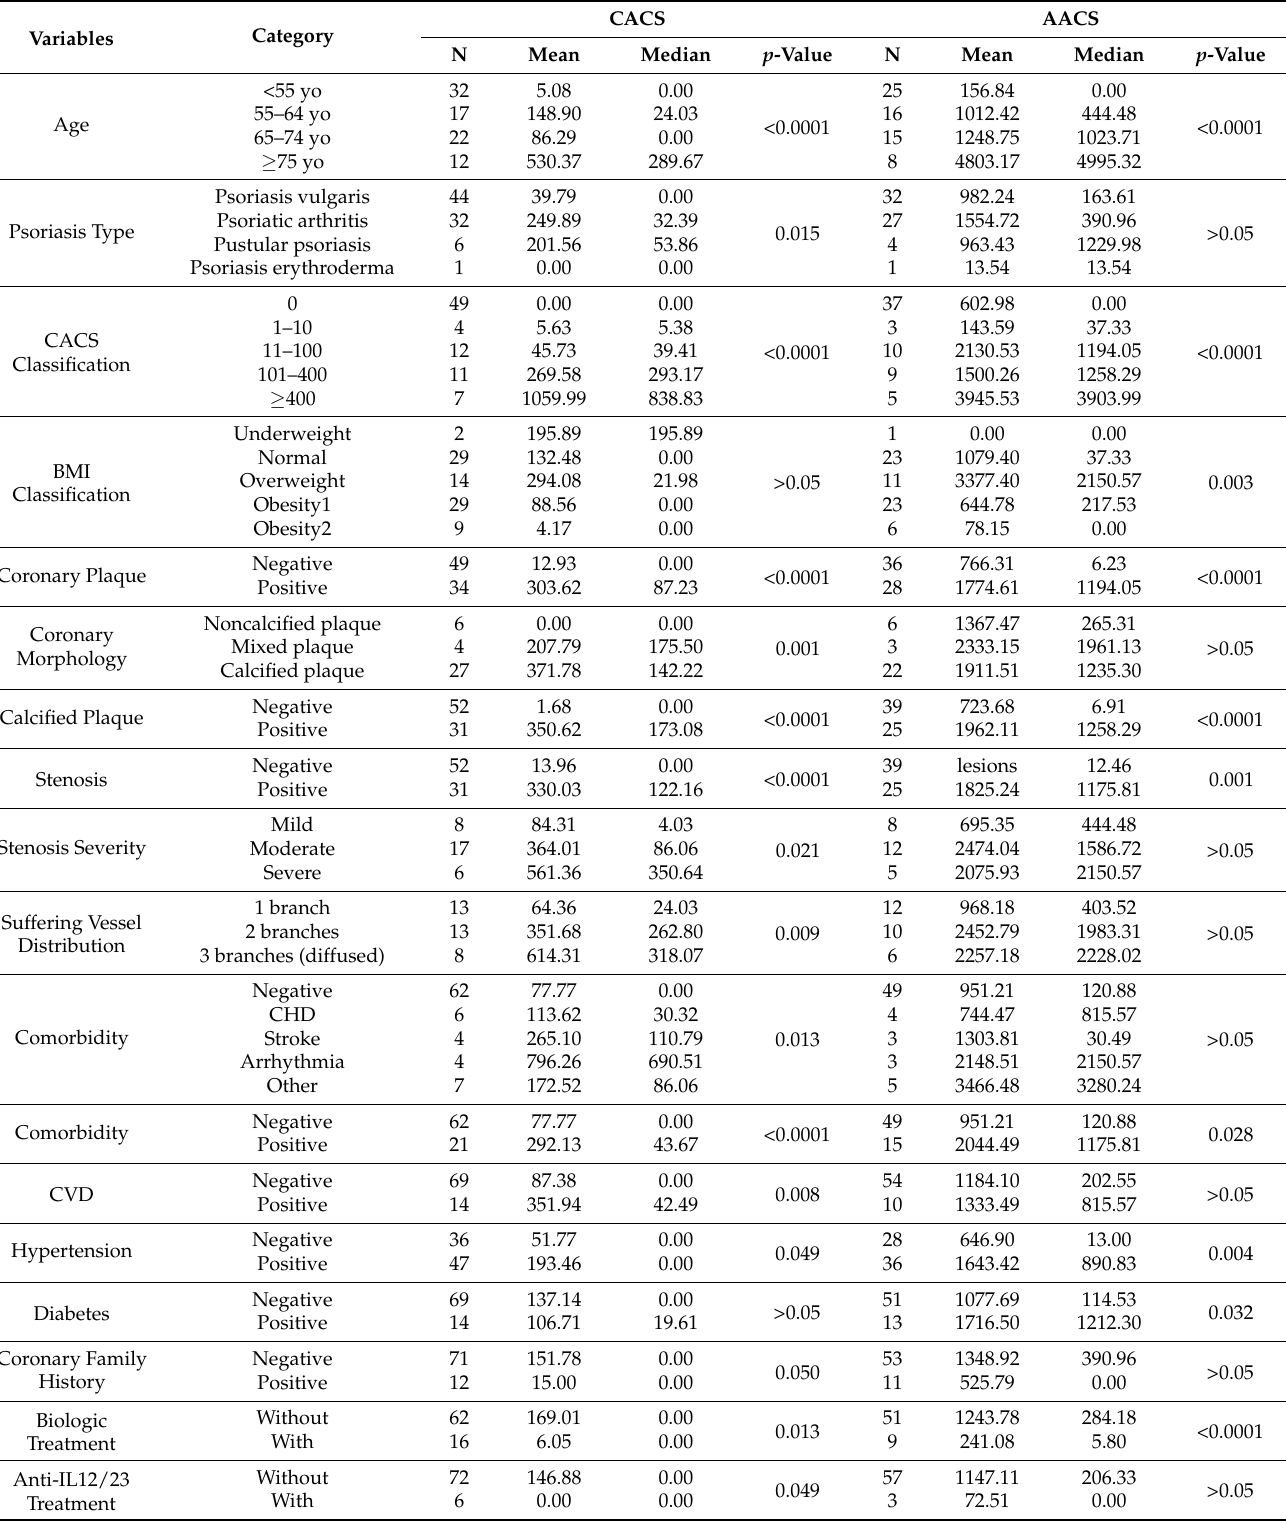
Table 6. Differences between CACS and AACS across subcategories of